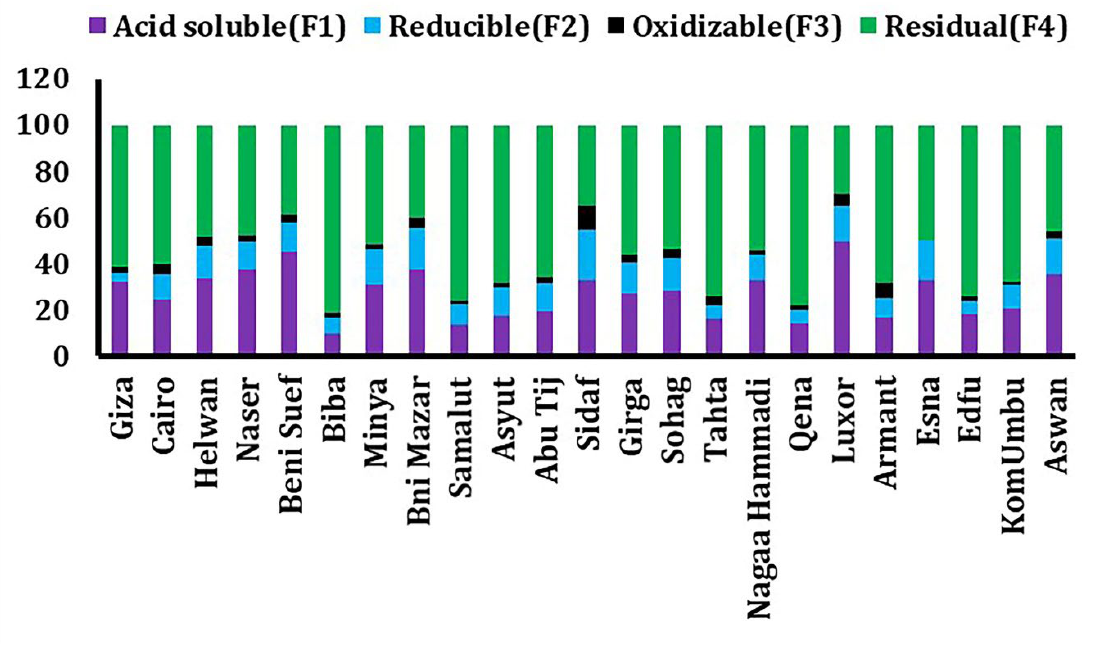
Figure 6. Results of Cd BCR sequential extraction fractions (%) and relative abundance in each location of sediment samples .